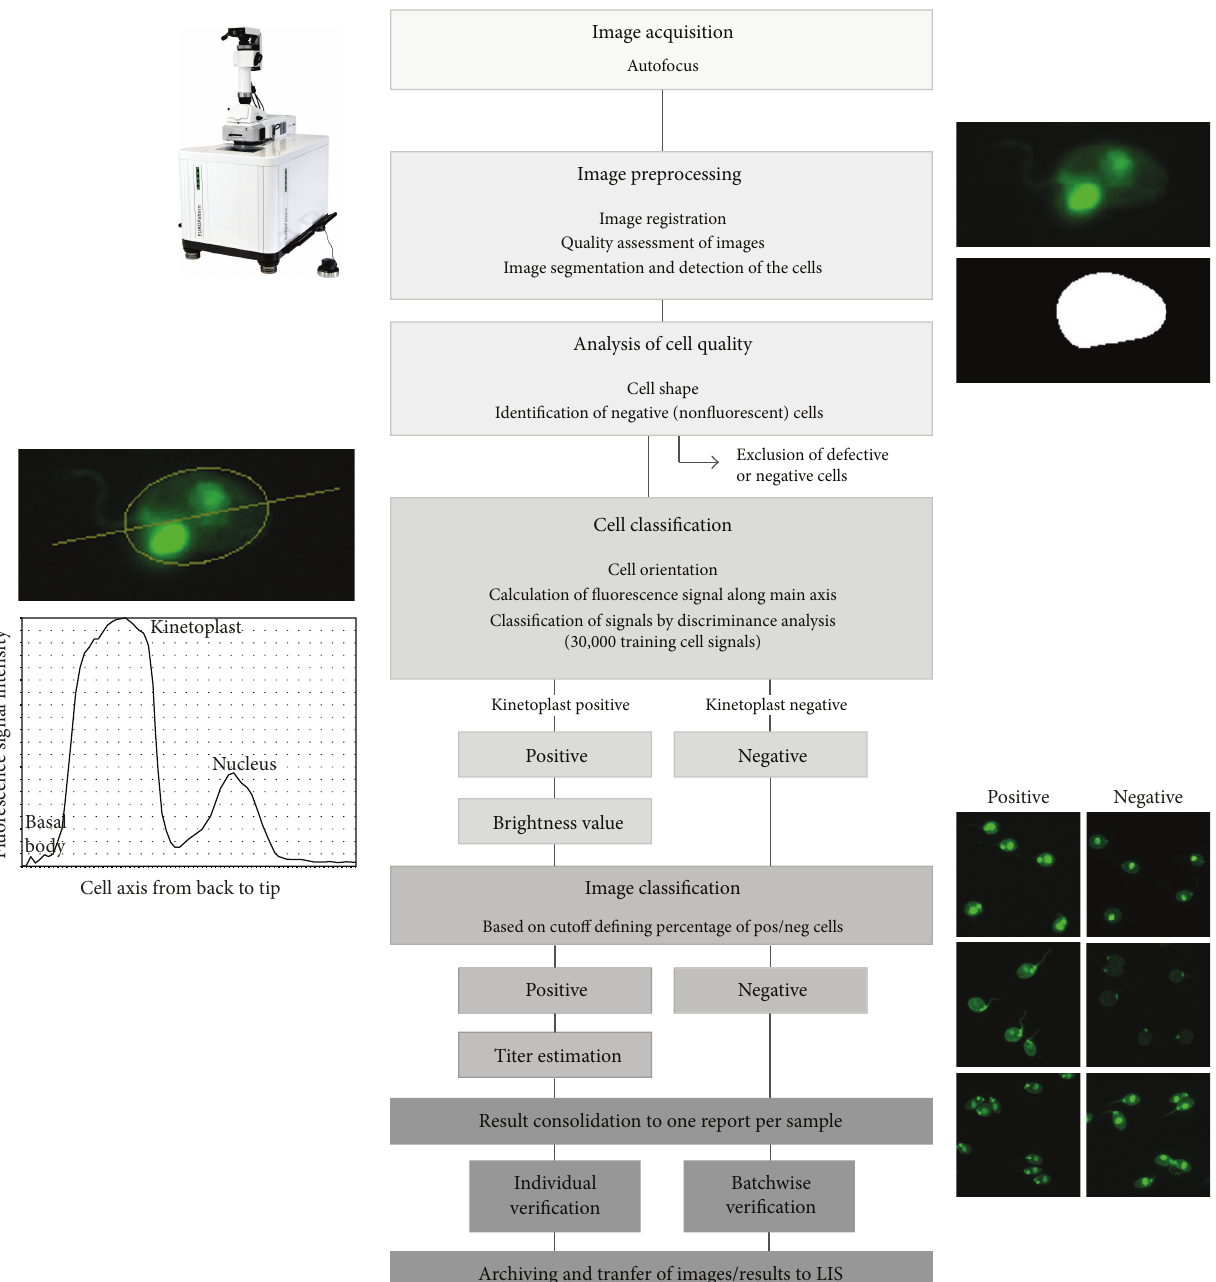
Figure 1: Flowchart of EUROPattern-Suite algorithm for computer-aided immunofluorescence microscopy of Crithidia luciliae IFT applied for the detection of antibodies against